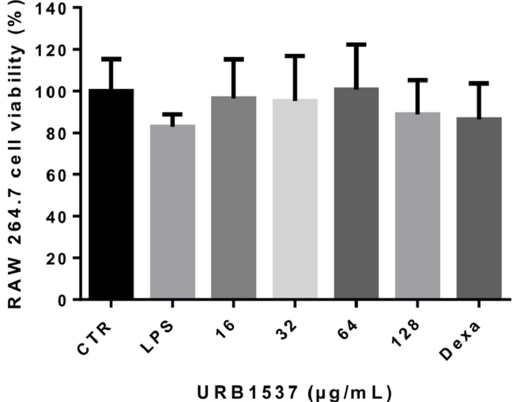
Figure 5. Cell viability evaluation after LPS (1 µg/mL), URB1537 (16–128 µg/mL), and dexametha-